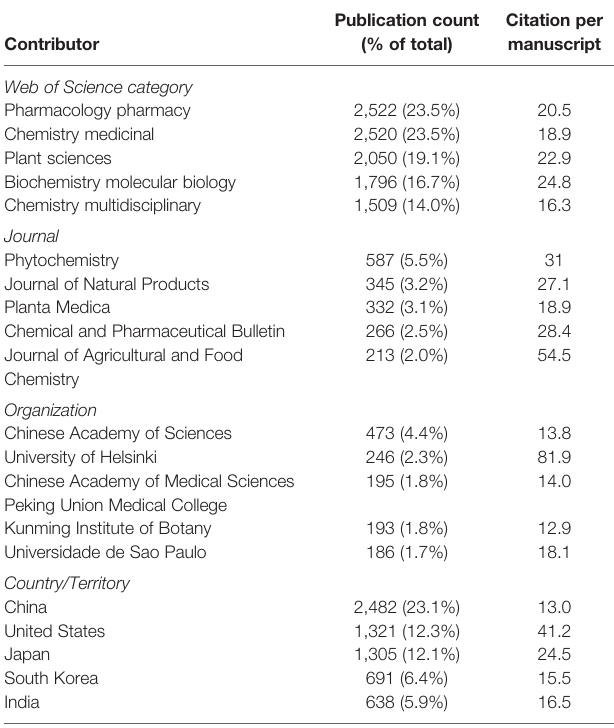
TABLE 1 | The top fi ve contributors in terms of Web of Science category, journal, institution, and country/region of publications concerning